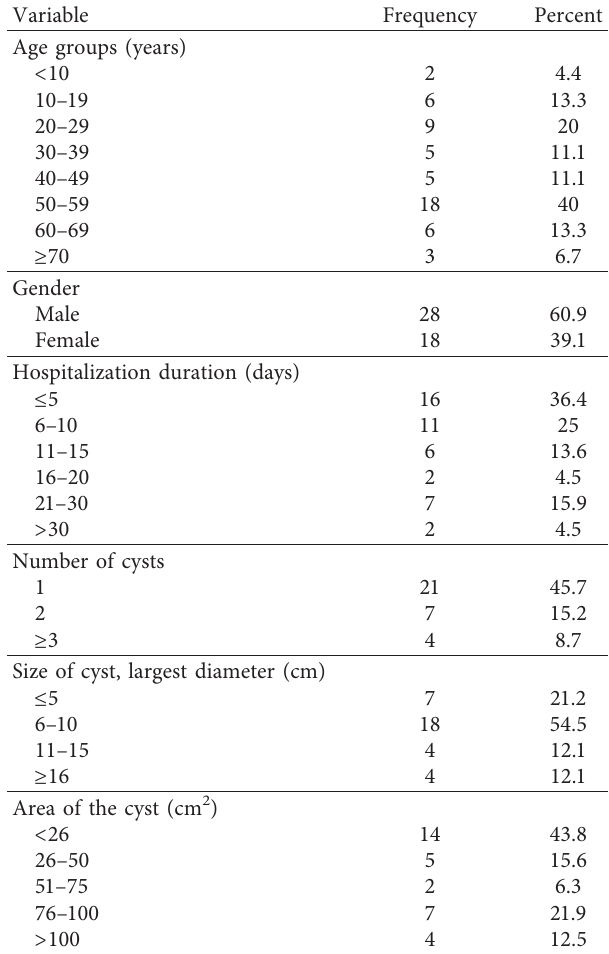
Table 2: Frequency of unusual locations of hydatid cyst and the simultaneous presence of cysts in unusual and common (liver and lung)